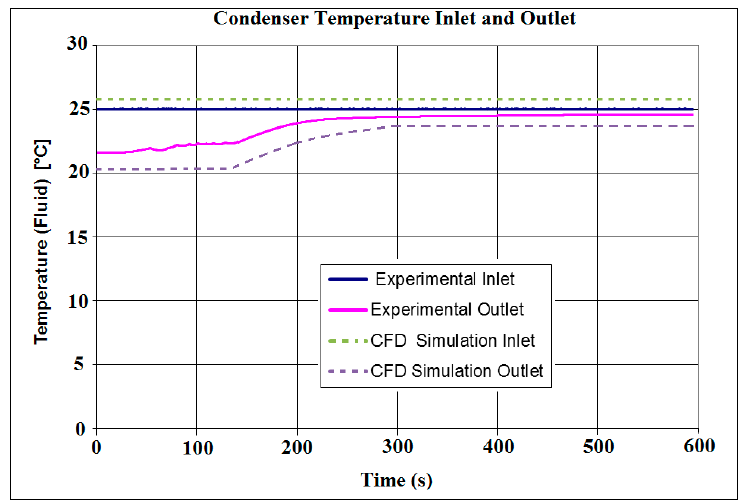
Figure 9. The refrigerant temperature in the condenser by J. White ©2012 [10].